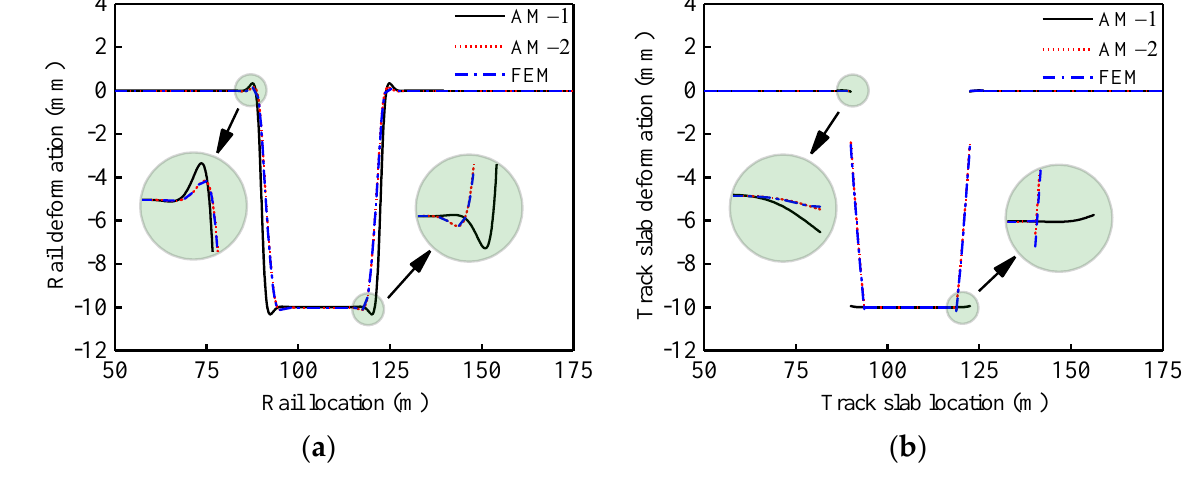
Figure 4. Case 1 ( a ) rail deformation; ( b ) track slab deformation.